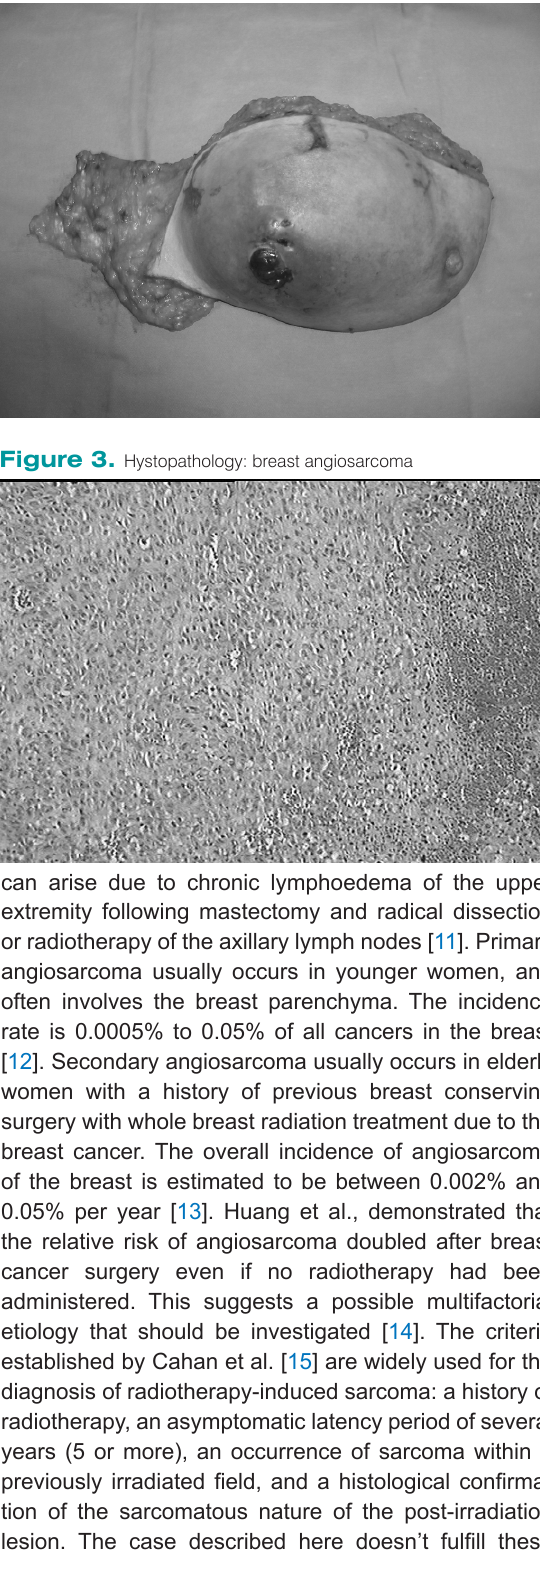
Figure 2. Right breast with tumor after mastectomy